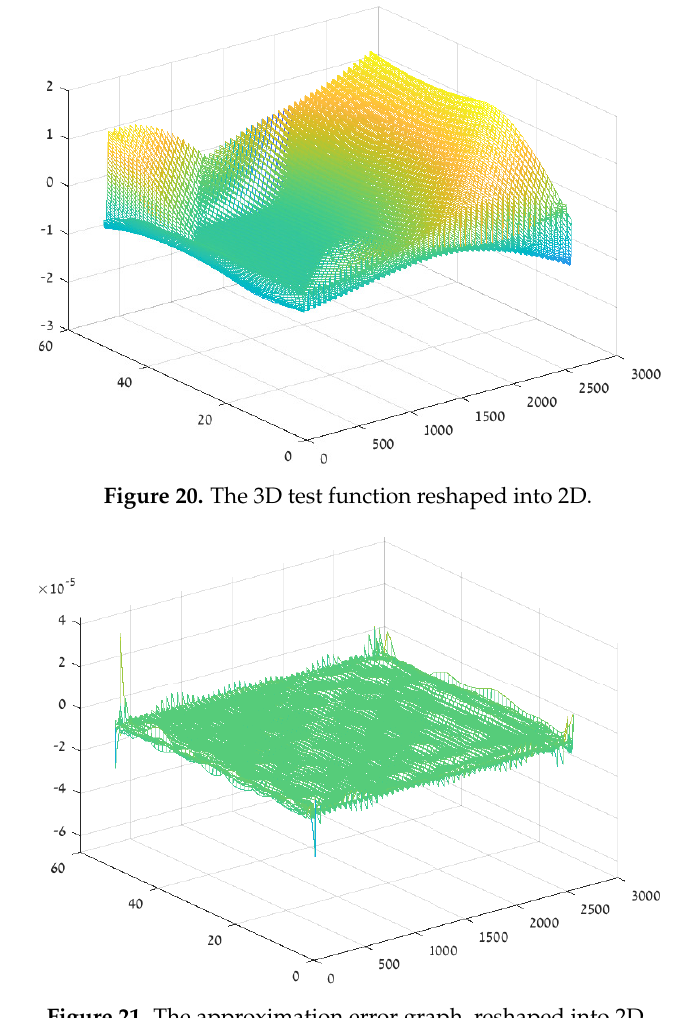
Figure 21. The approximation error graph, reshaped into